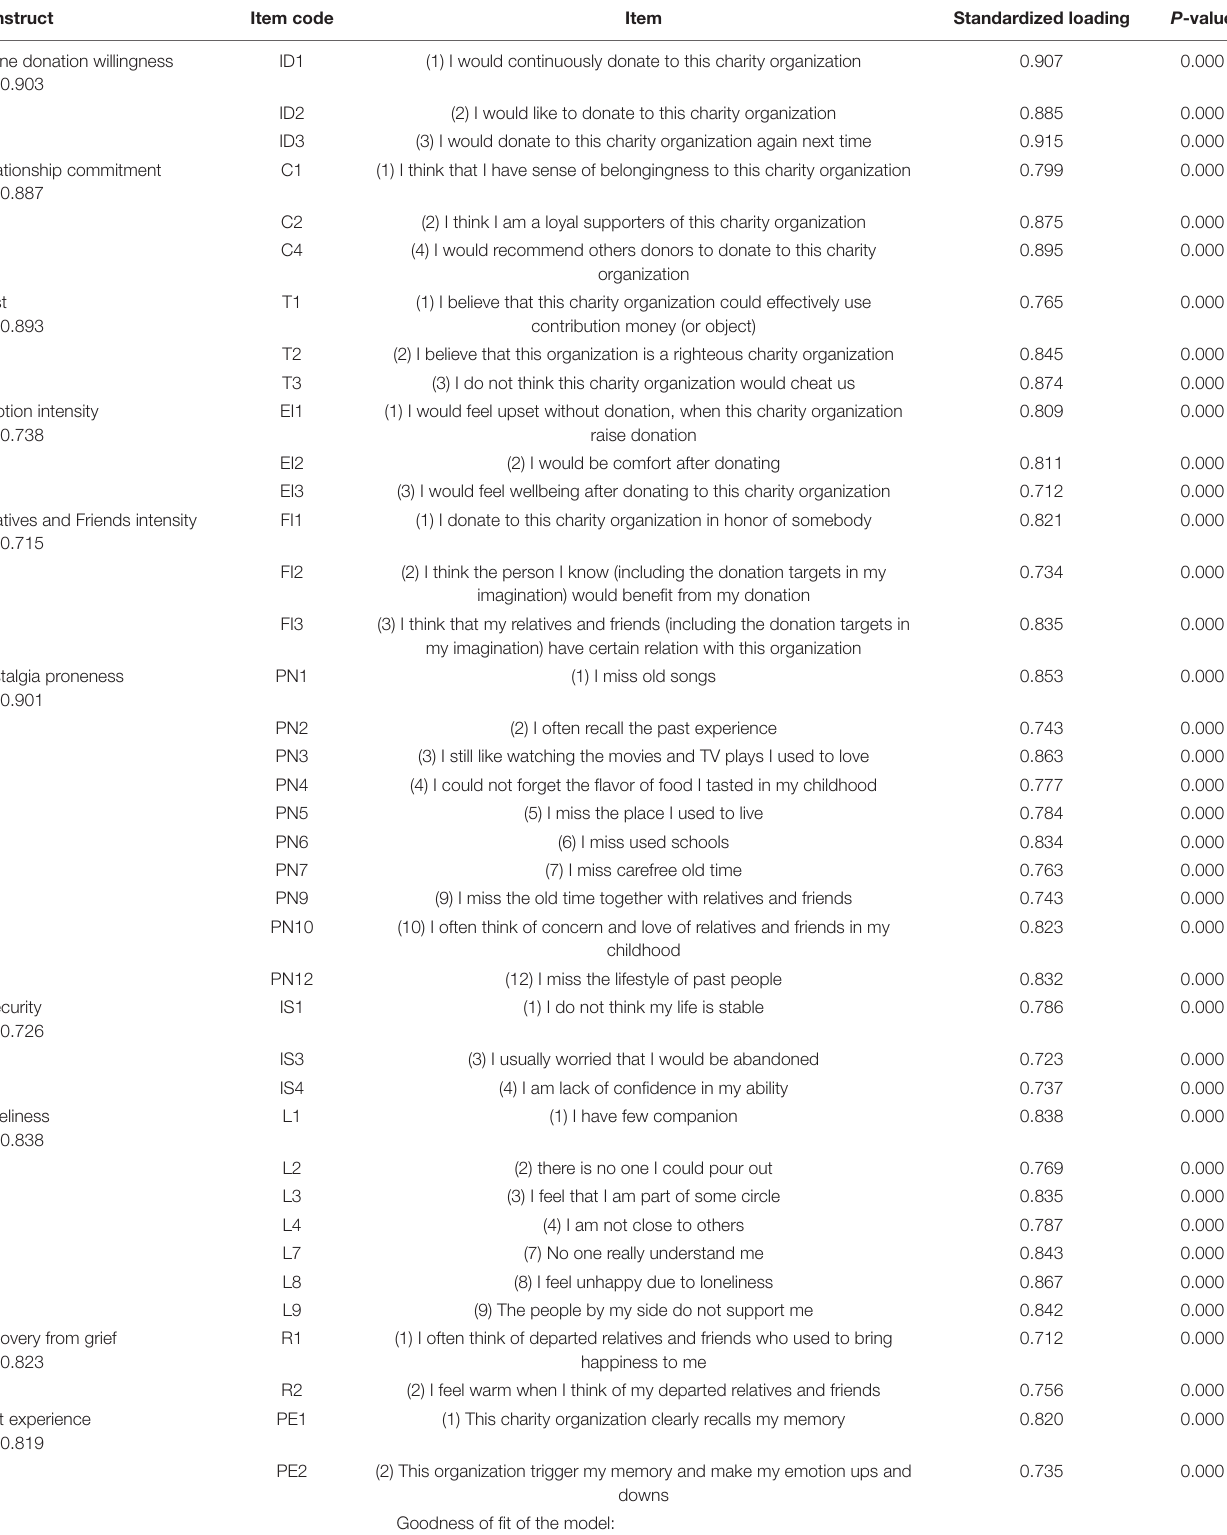
TABLE 2 | Confirmatory factor analysis of